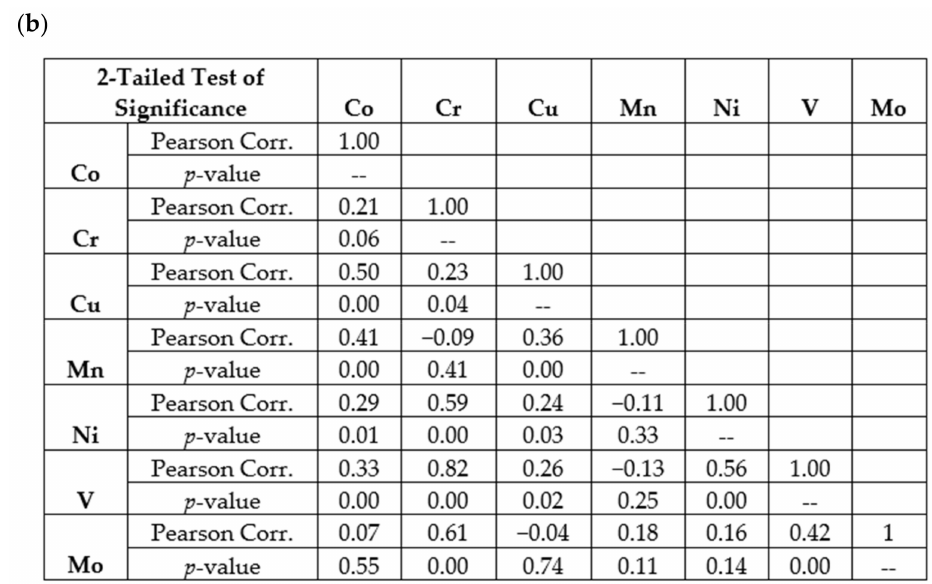
Figure 7. Multivariate statistical analysis of trace elements ( a ) dendrogram derived from hierar- chical cluster analysis, cluster method: nearest neighbour, and distance type: absolute correlation, ( b ) Pearson Correlation matrix and p -values using two-tailed test of